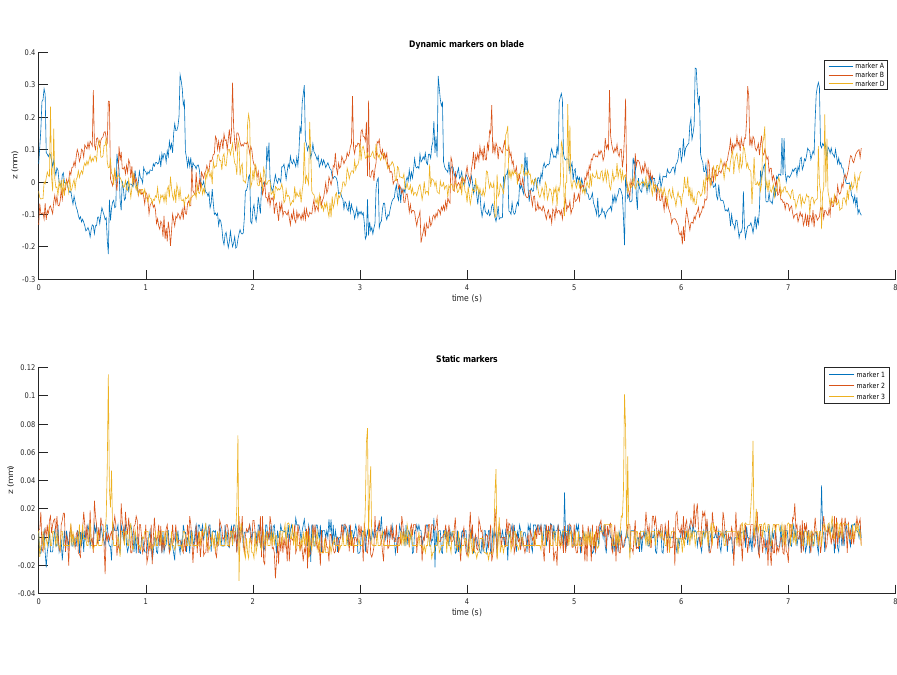
Figure 10. Out-of-plane error over time.